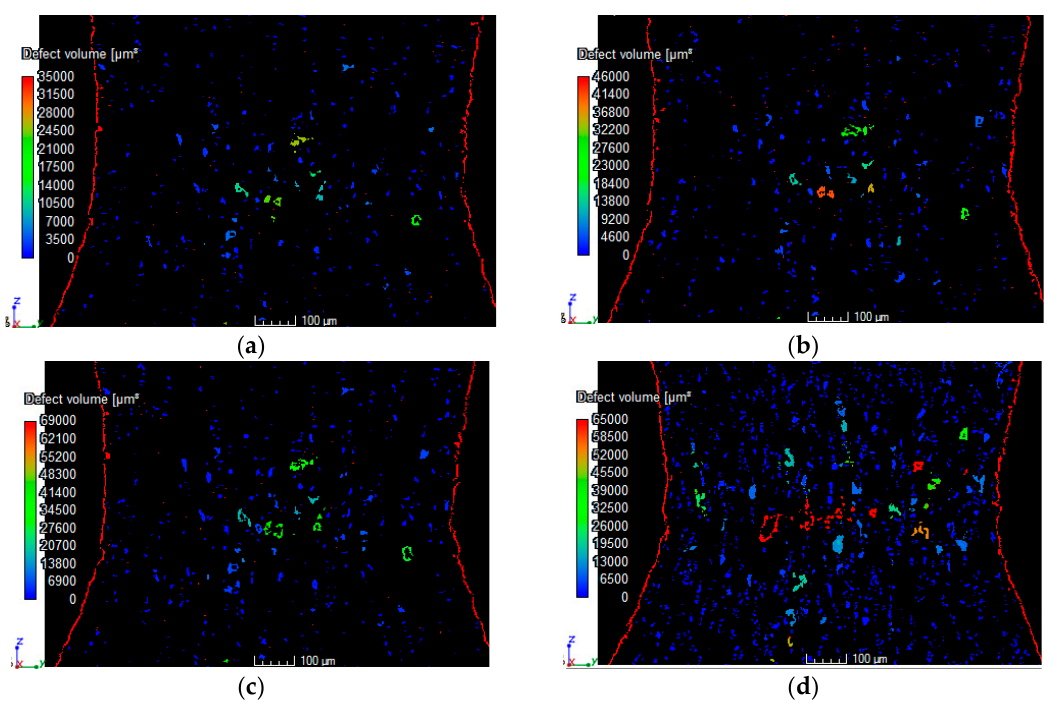
Figure 13. Ti-MMC, σ = 150 MPa, T = 510 ◦ C, 2D longitudinal section through tomogram: ( a ) 0.94 t fr ; ( b ) 0.95 t fr ; ( c ) 0.96 t fr ; ( d ) 0.98 t fr